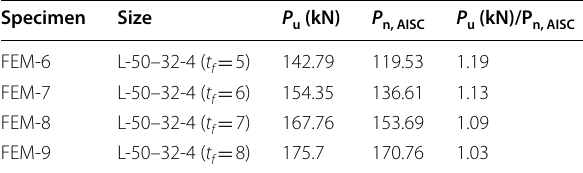
Table 5 Comparison of simulation results and calculation